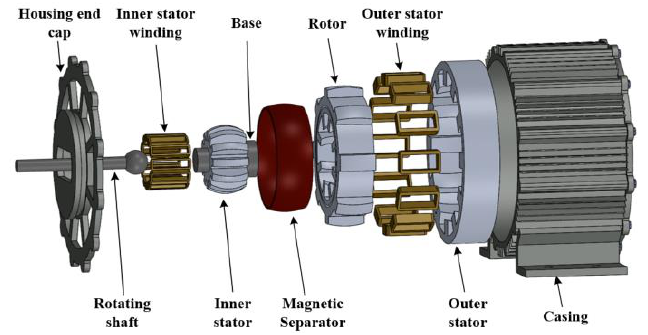
Figure 2. Overall structure distribution of DDSRG.